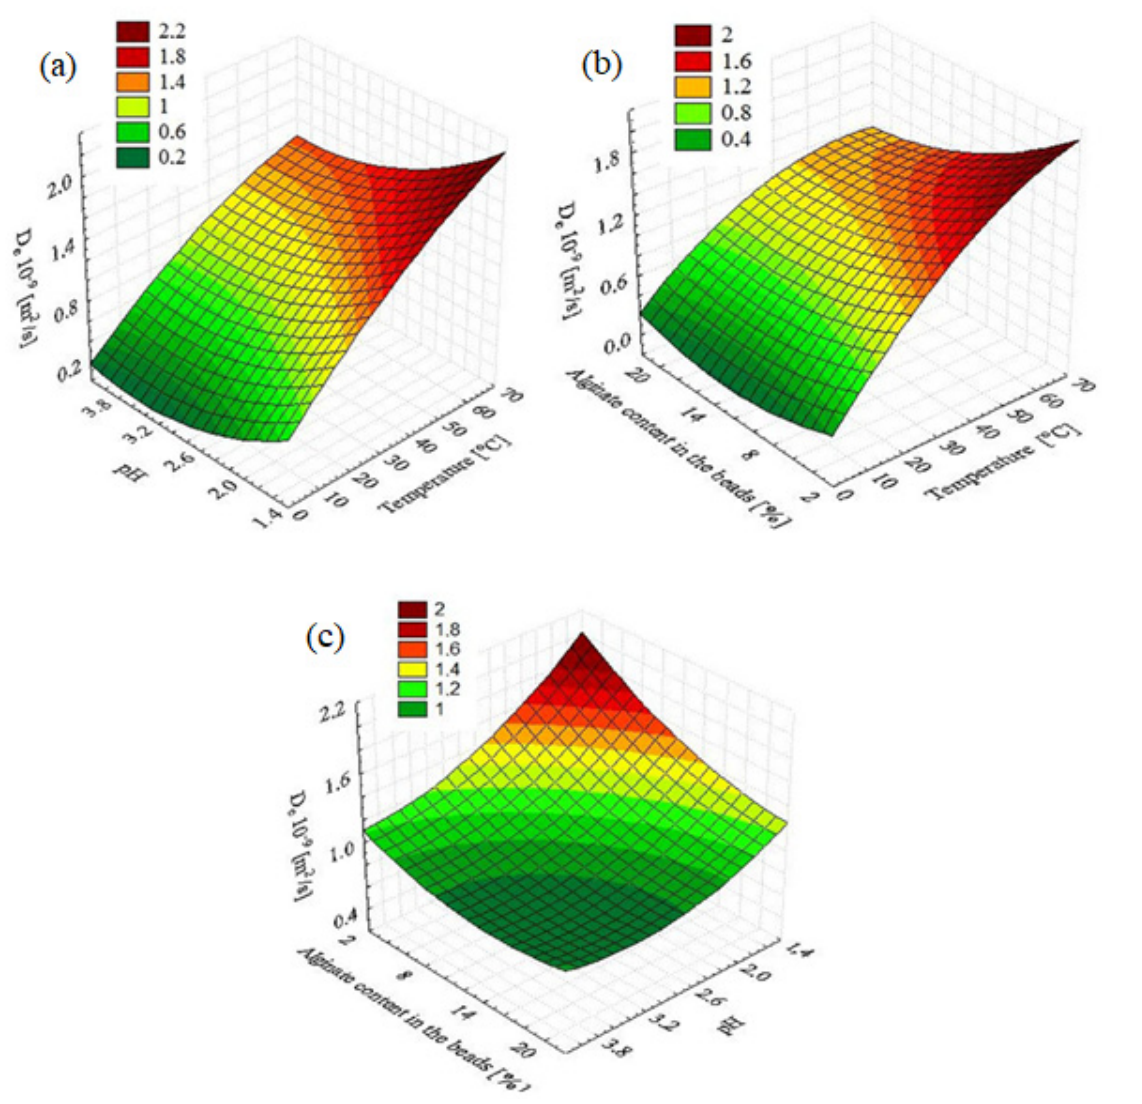
Figure 3. Response surface plots for biosorption process. The effect of ( a ) temperature and pH, ( b ) temperature and alginate content in the beads, and ( c ) alginate content in the beads and pH.